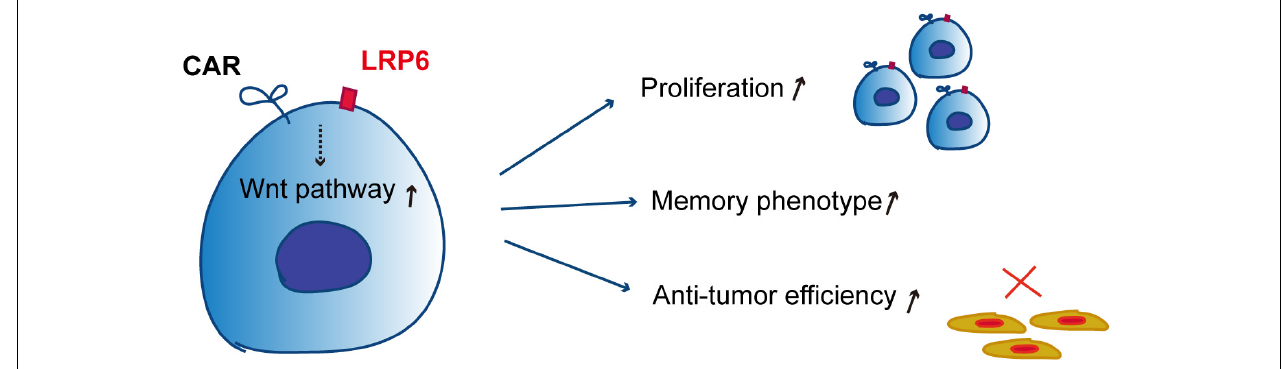
FIGURE 5 | Schematic of the mechanism of co-expression of LRP6 and CAR-T. The co-expression of LRP6 with α 19BBZ could sustain the memory phenotype and exhibit a greater ability of proliferation and anti-tumor capacity in vitro and in vivo by enhancing the wnt-signaling